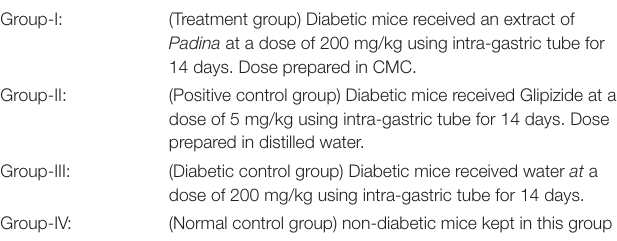
Frontiers in Plant Science |